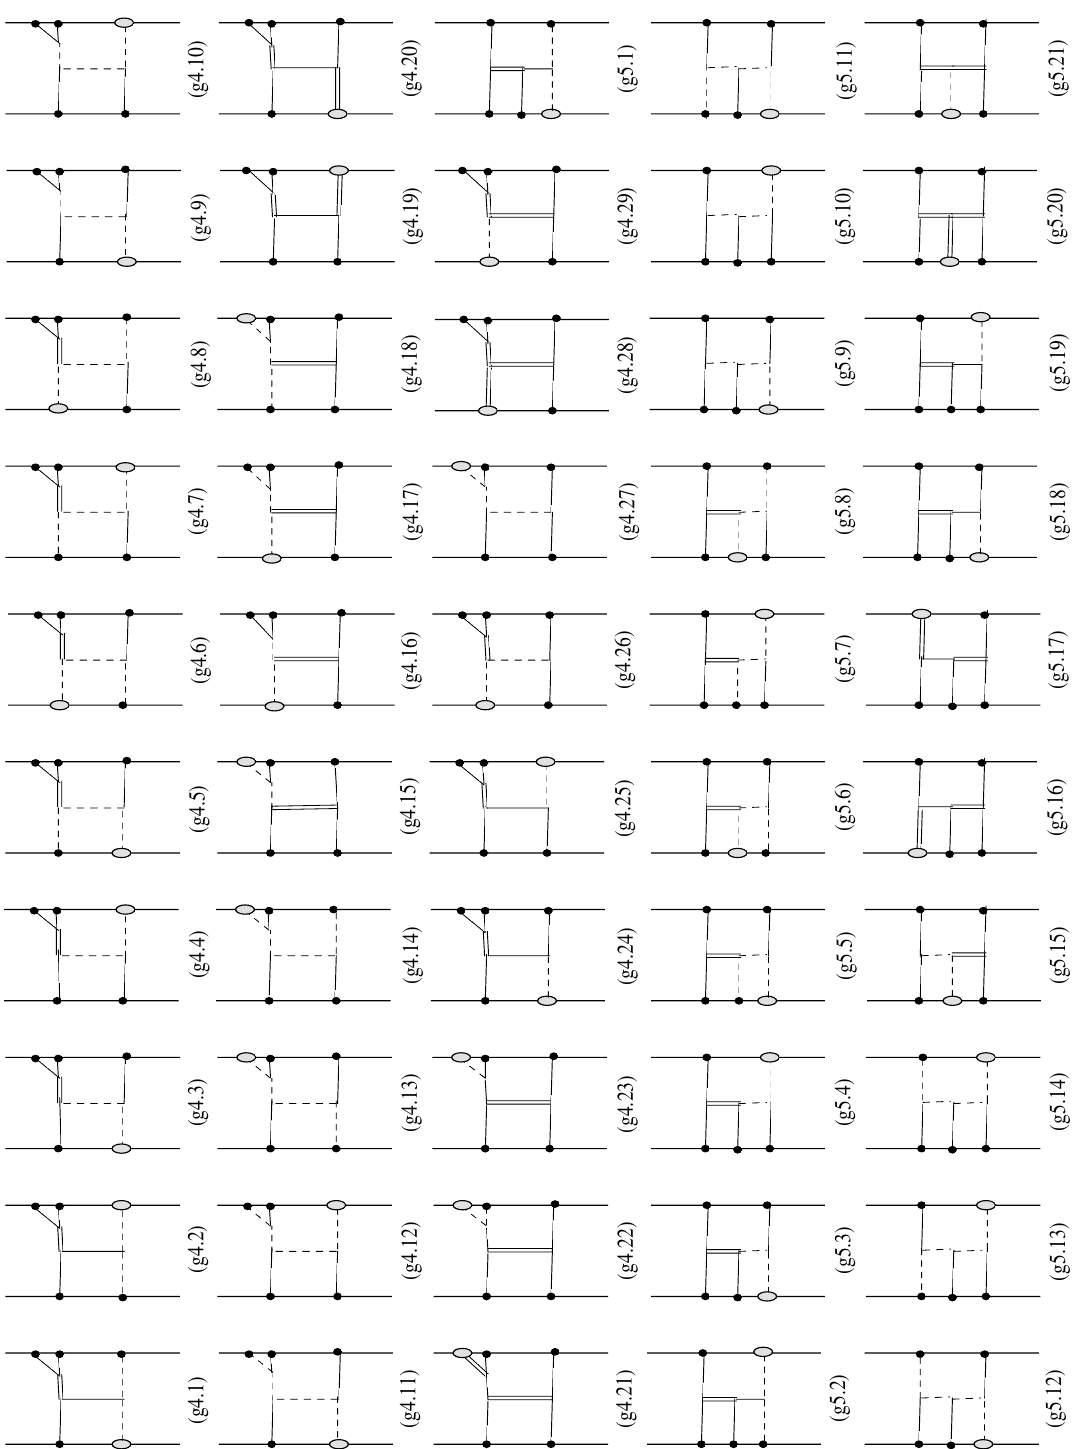
Figure 11 . Feynman graphs which contribute to the N 3 LO spin-orbit coupling at G 4 . This figure contains all graphs with topologies (g4)-(g5) of figure 4. These are rank-three topologies that are deferred in the non-spinning sector to the N 4